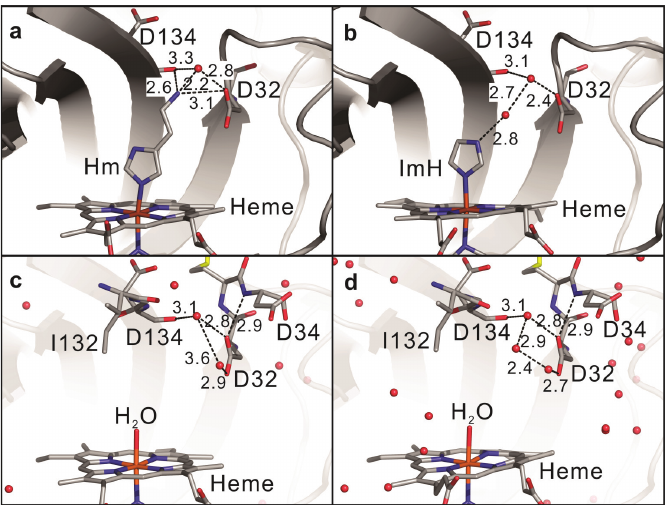
Figure 6. Local structural details of the heme pocket. ( a ) Hm, ( b ) ImH, ( c ) pH 5.8 and ( d ) pH 7.8. The numbers represent the bond distances